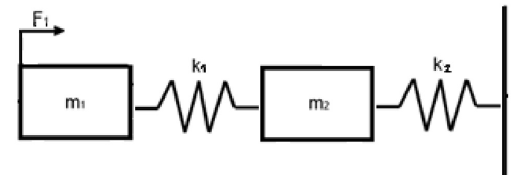
Figure 3. A mechanical cascade model assumed for the purposes of this article consists of two masses ( m 1 ; m 2 ) and two springs ( k 1 ; k 2 ). The model is constrained to a rigid surface with a spring k 2 and is being excited by an external force F 1